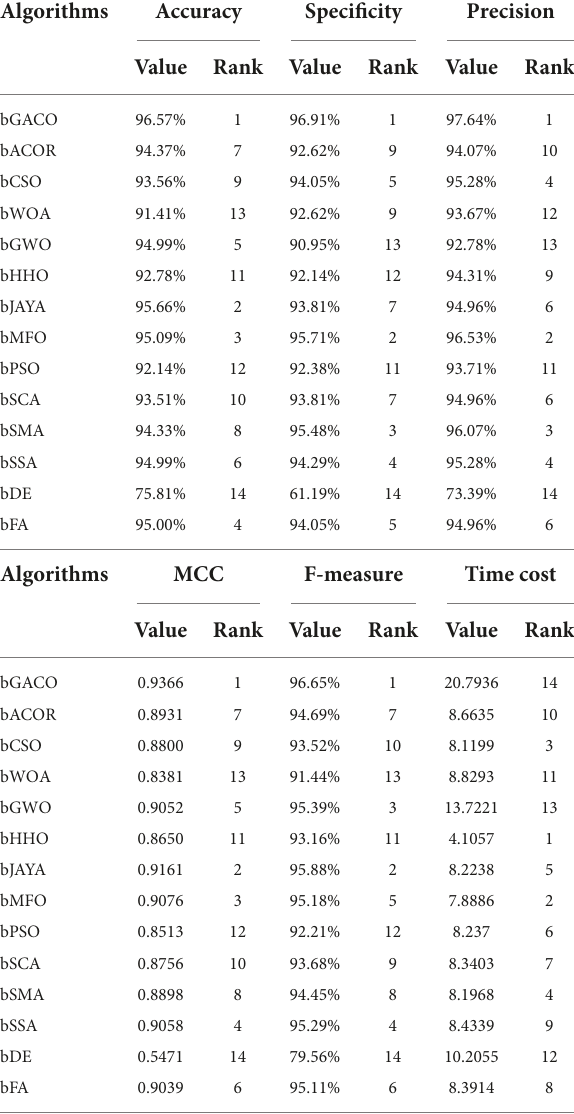
TABLE 16 Average values of 10 methods in the six